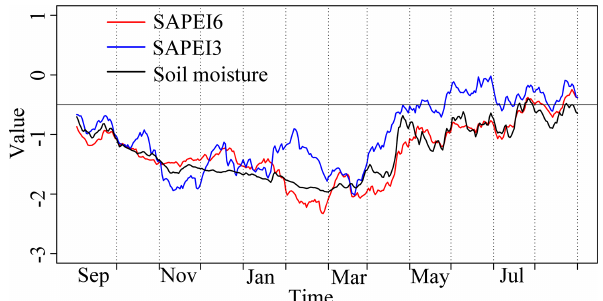
Figure 5. SAPEI and soil moisture series during the 2009/2010 drought event over southwestern China. The spatially averaged se- ries are shown. The value of the solid black line is at − 0 . 5, indicat- ing the distinction between drought and non-drought conditions.